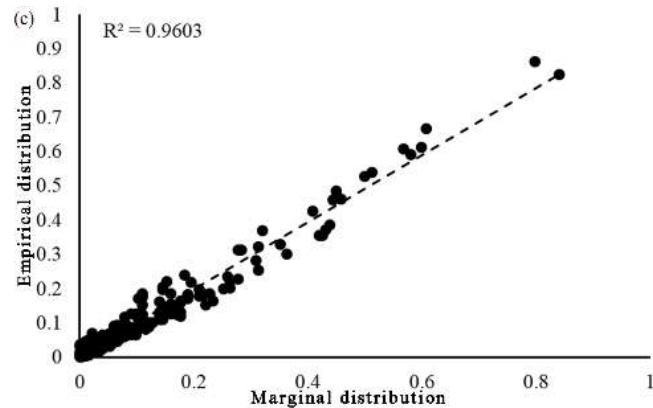
Figure 3. Comparison of the sample empirical distribution and marginal distribution: ( a ) pair of (Q, NH 4+ ); ( b ) pair of (Q, COD Mn ); and, ( c ) pair of (Q, NH 4+ , COD Mn ).